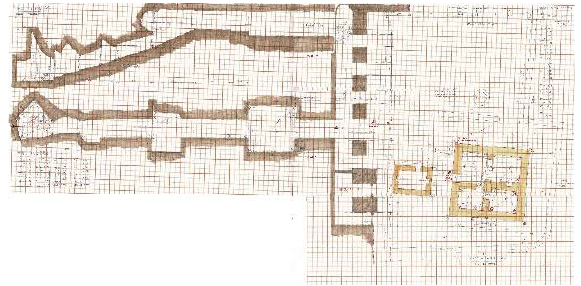
Figure 5. Work’s drawing of Ipi’s tomb (plan and cross section). Measures and preliminary possible positions of 3D scanner.